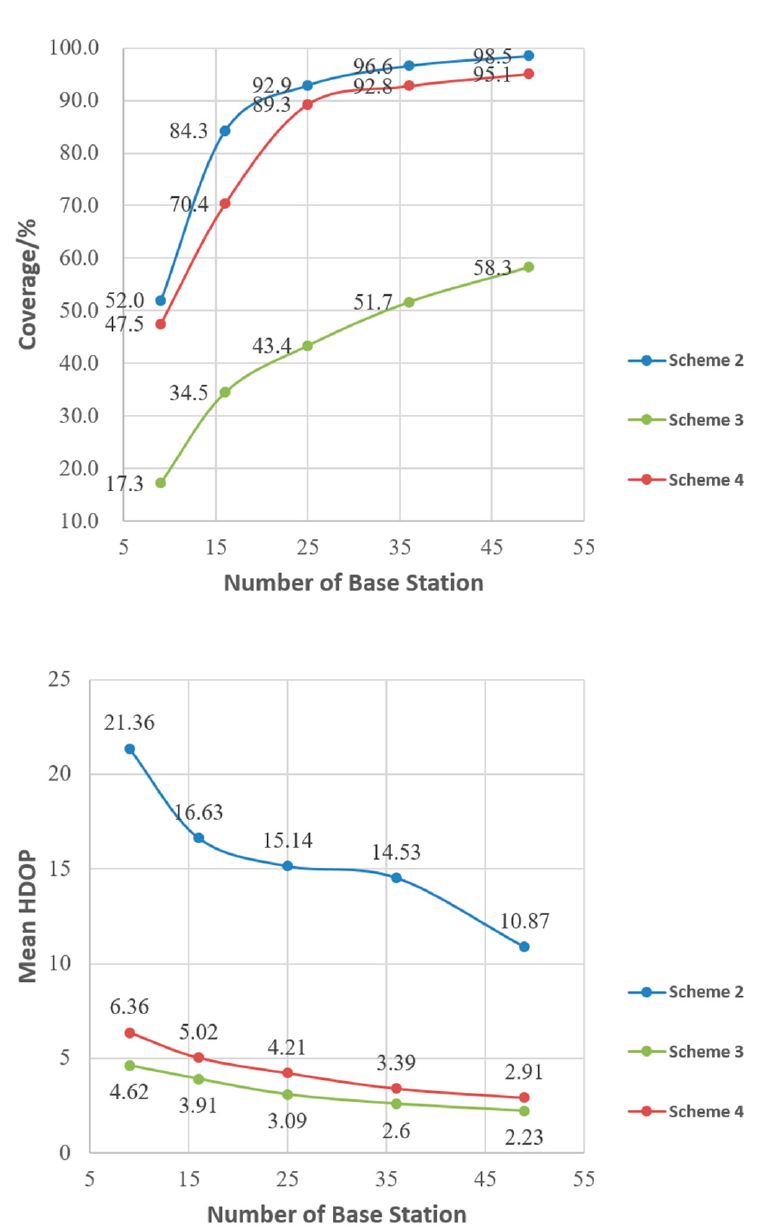
Figure 9. Coverage, mean HDOP, and the number of base stations under the three schemes. The comparison between Scheme 3 and Scheme 4 shows that the particle swarm optimization algorithm of Scheme 3 only optimizes the geometry of the pseudolite system with a single objective and has a smaller average HDOP. Scheme 4 needs to consider the coverage of the pseudolite system at the same time, so the average HDOP of the system is about 24.6% higher than that of Scheme 3. However, the coverage of the pseudolite system is not considered in Scheme 3, so the coverage of Scheme 4 is 49.8% higher than that of Scheme